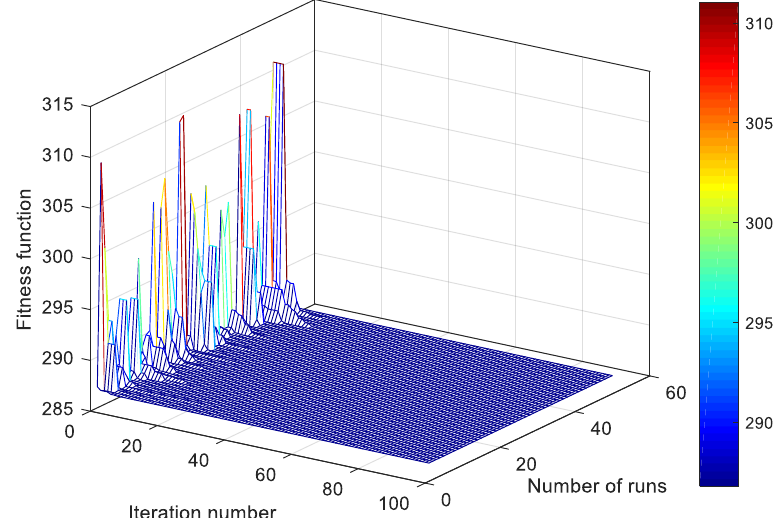
Figure 13. Number of runs versus iteration number and fitness function.